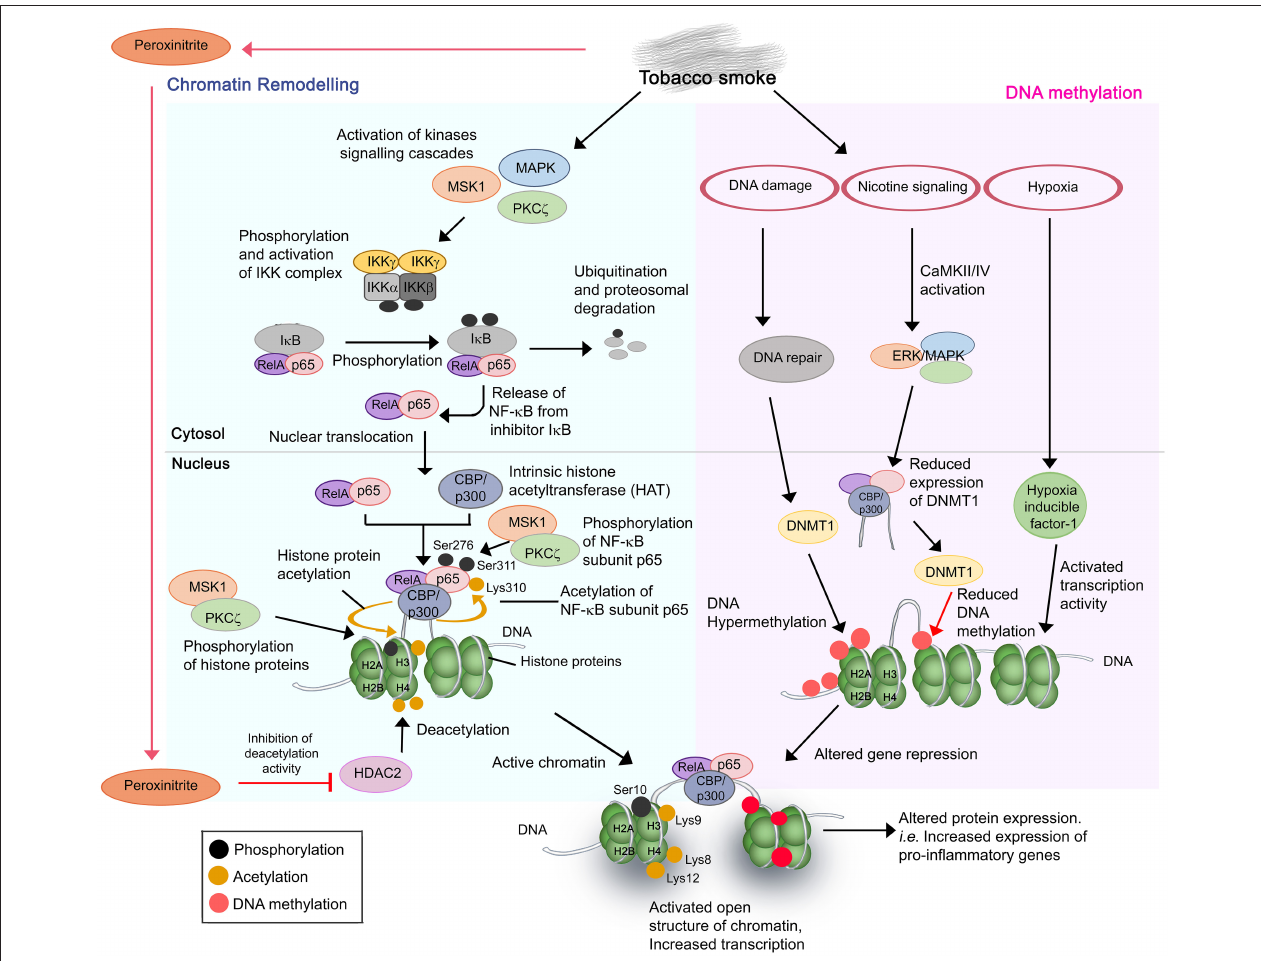
FIGURE 1 | Cigarette and tobacco smoke has several effects on gene regulation. Nicotine and other compounds in the smoke alter gene expression by two pathways, firstly, chromatin remodeling (Left) and secondly, DNA methylation (Right) . Chromatin remodeling involves activation of kinases signaling pathways, activation and nuclear translocation of transcription factor NF- κ B (RelA/p65), and complex formation with CBP/p300 on specific DNA sites. CBP/p300 is intrinsically a histone acetyltransferase (HAT). Subunit p65 is further phosphorylated at Ser276 and Ser311, respectively, by MSK1 and PKC ζ , whereas CBP acetylates p65 at Lys310. The phosphorylation and acetylation enhance the interaction within the NF- κ B/CBP/p300 complex while stabilizing the DNA binding of NF- κ B. The complex of NF- κ B/CBP/p300 then modifies the histones through CBP-mediated acetylations of histone H3 (at Lys9) and H4 at Lys 8 and Lys12, and phosphorylation of H3 at Ser10 by MSK1 and PKC ζ . This results in the structure change of chromatin, from a condensed structure (repressed) to an activated open conformation. The transcription of target genes is therefore increased. In the second mechanism, several side effects resulting from cigarette smoking such as DNA damage and nicotine signaling could trigger the hypermethylation or decreased methylation of target DNA. This may lead to DNA methylation anomalies and thus altered DNA expression. Resulting hypoxia due to high concentrations of carbon monoxide also contributes to altered gene expression. The aberrant gene expression by cigarette smoke mostly occurs in pro-inflammatory genes with resulting increased production of inflammatory mediators, and amplified inflammation in the COPD lung upon